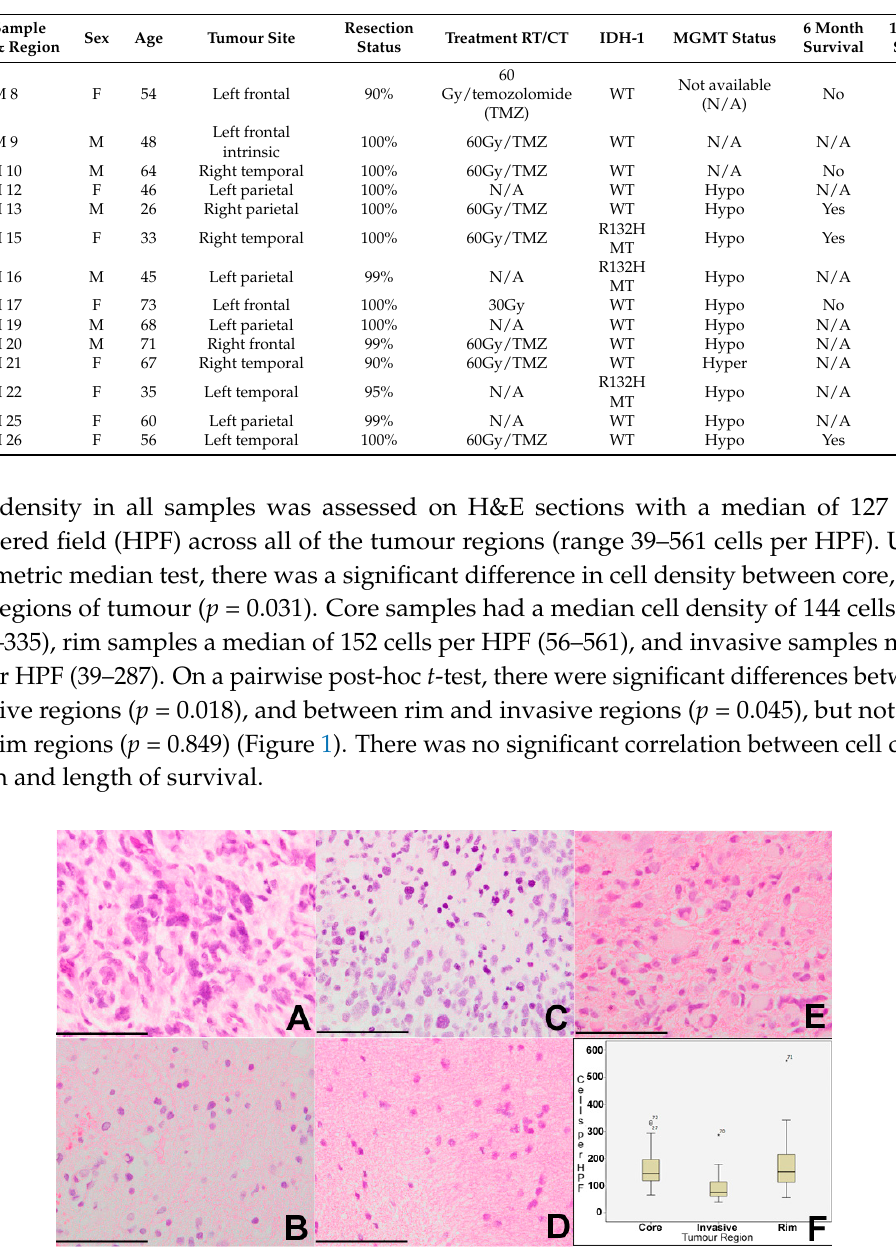
Table 1. Clinical data for GBM patients. All 14 GBMs presented as primary tumour cases. WT, wild-type; MT, mutant. Tissue Sample Number&Region Sex